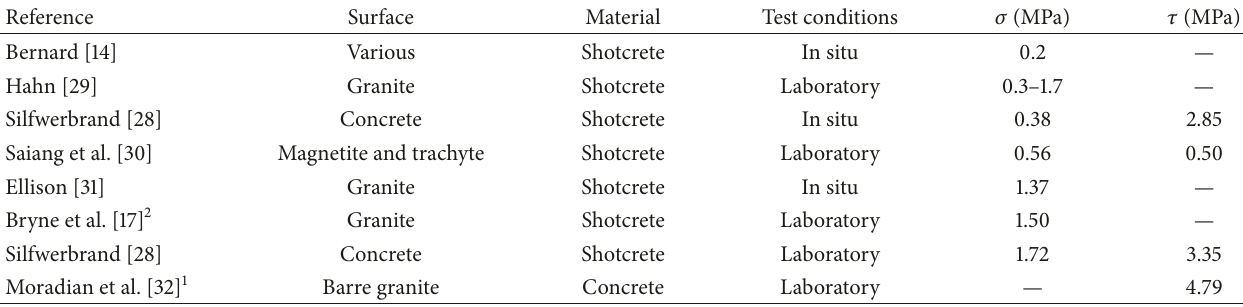
1 Results are mean values from presented results with a bonding of 100 % . 2 Results are mean values after three days of curing. Table 2: Material parameters for the damage plasticity model. See Figure 1 for explanation of material parameters. Shotcrete Slab